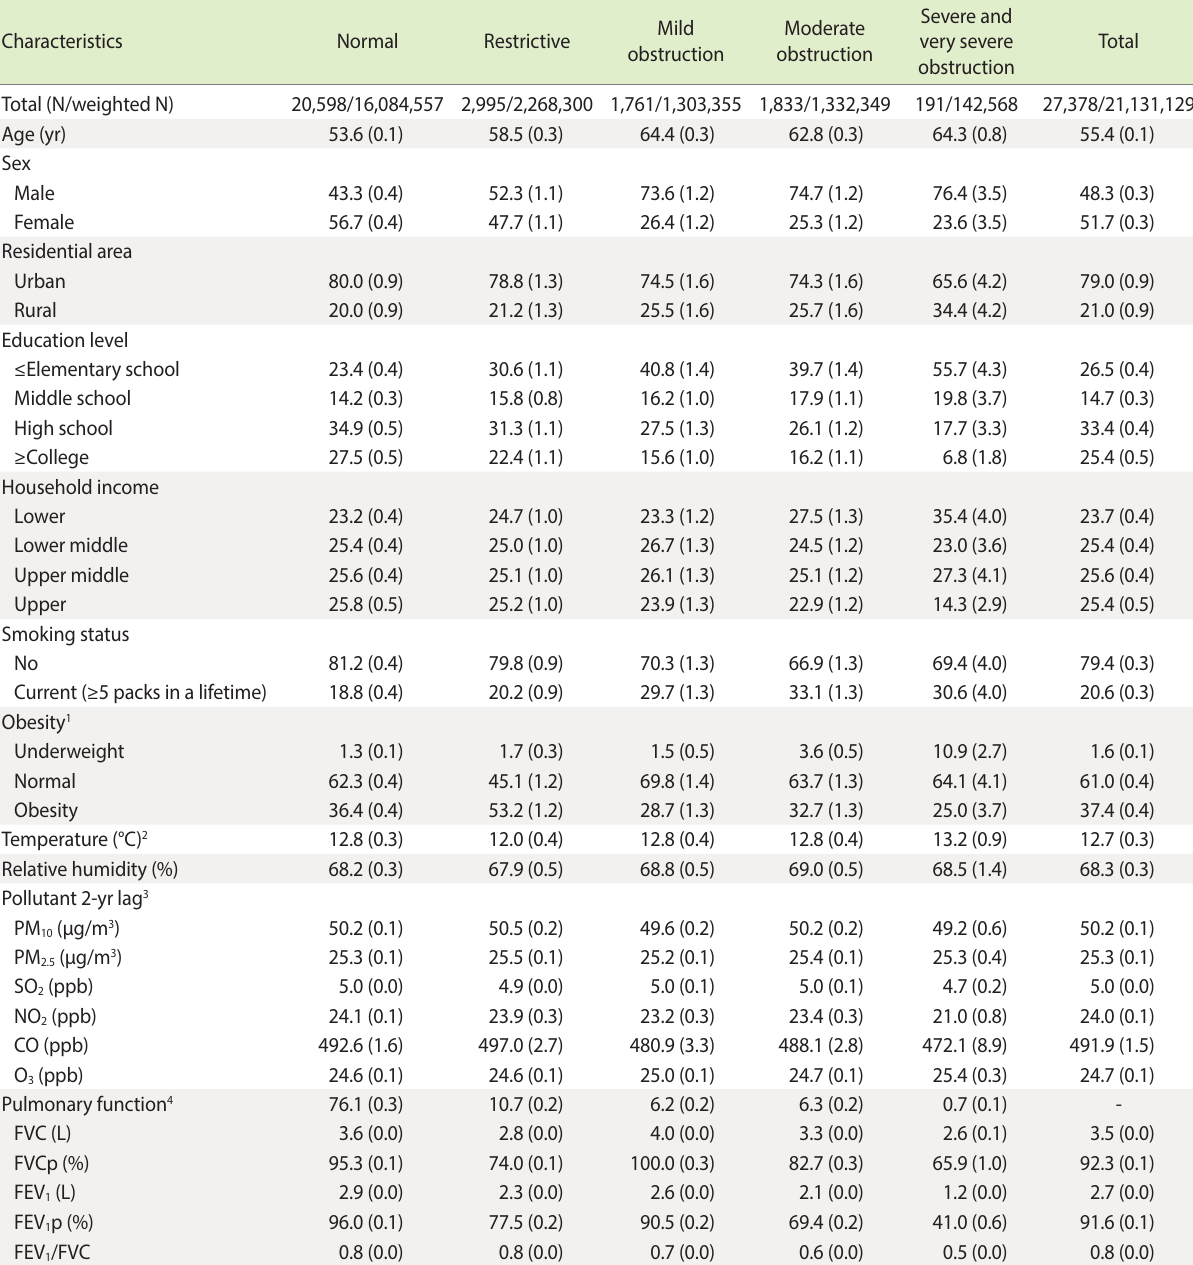
Table 1. Characteristics of participants stratified by pulmonary function